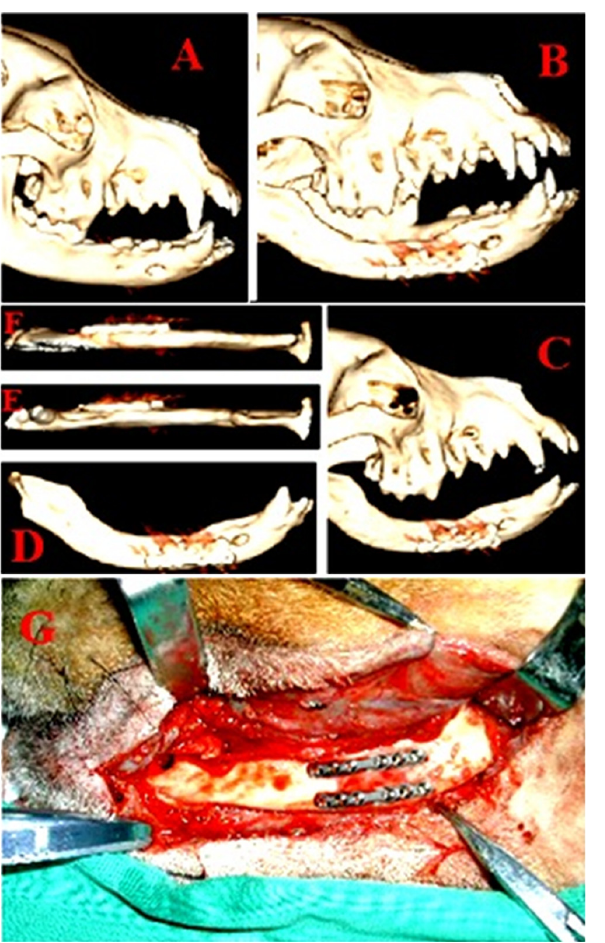
Fig. 2. A: CT scanning image of No. 1 beagle in Group A be- fore surgery; B: scanning image of No. 2 beagle in Group A on the 90th postoperative day; C: scanning image of No. 2 beagle in Group B on the 90th postoperative day; D-F: local scanning images of No. 2 beagle in Group A on the 90th postoperative day; G: naked-eye observation of No. 3 beagle in Group A on the 90th postoperative day.